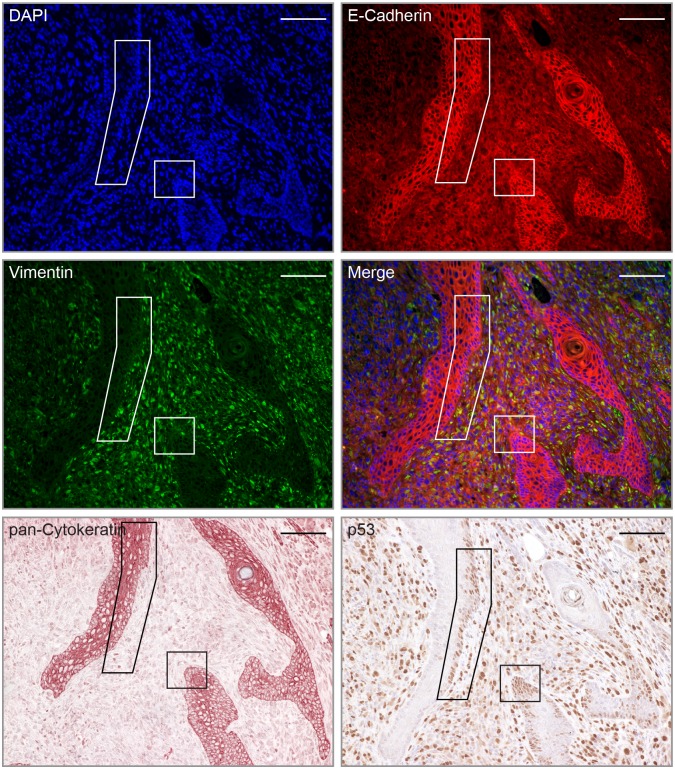
Dedifferentiation correlates with positive p53 staining.Consecutive sections of a poorly differentiated nKSCC were stained with antibodies against E-cadherin, vimentin, pan-Cytokeratin and p53. DAPI was used as nuclear counter stain. Note that in this tumor, only mutation R266C could be detected (Scale bars: 100 μm).